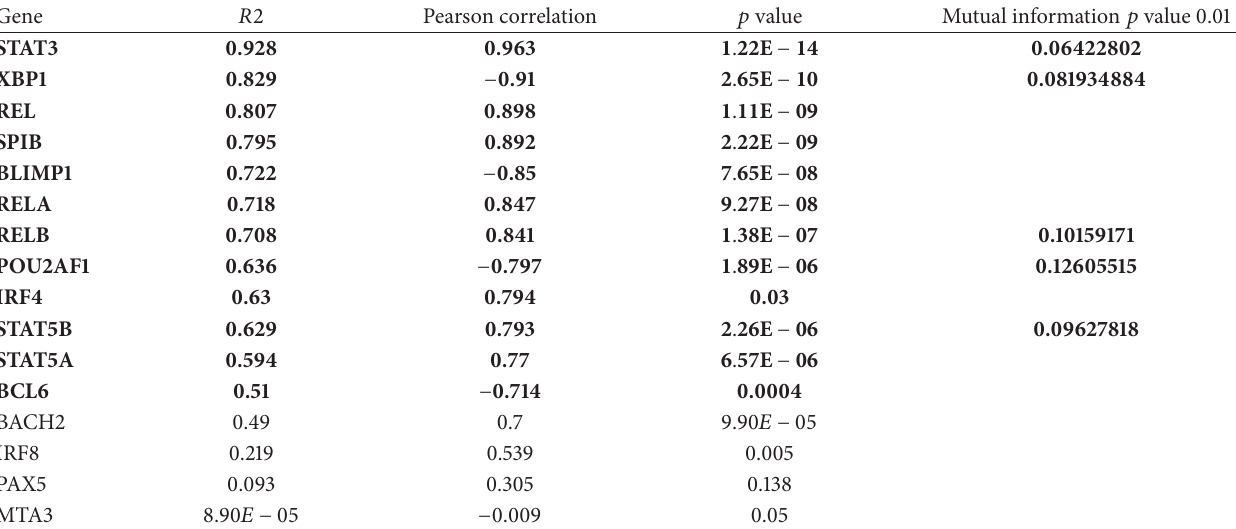
Figure 5: The correlation between IFI16 and selected transcription factors was determined by GEP in normal B-cell subsets. The data are shown in a bivariate scattergram with a regression line. IFI16 is plotted on the 𝑦 -axes, while BCL6 , BLIMP1 , XBP1 , POU2AF1 , STAT3 , STAT5A , STAT5B , SPIB , RELA , RELB , REL , and IRF4 are plotted on the 𝑥 -axes in panels (a) to (l), respectively. Note that plasma cells were eventually excluded from the analyses between IFI16-BCL6 and IFI16-IRF4 . In fact, based on our analysis, IFI16 expression was suppressed by other molecules in plasma cells, making them not suitable for an appropriate evaluation of the relationship between IFI16 and BCL6 or between IFI16 and IRF4 . Table 2: Relation of IFI16 with themain transcription factors regulating B-cell fate in termsof correlation, regression, and mutual information (in bold, genes with significant correlation and regression